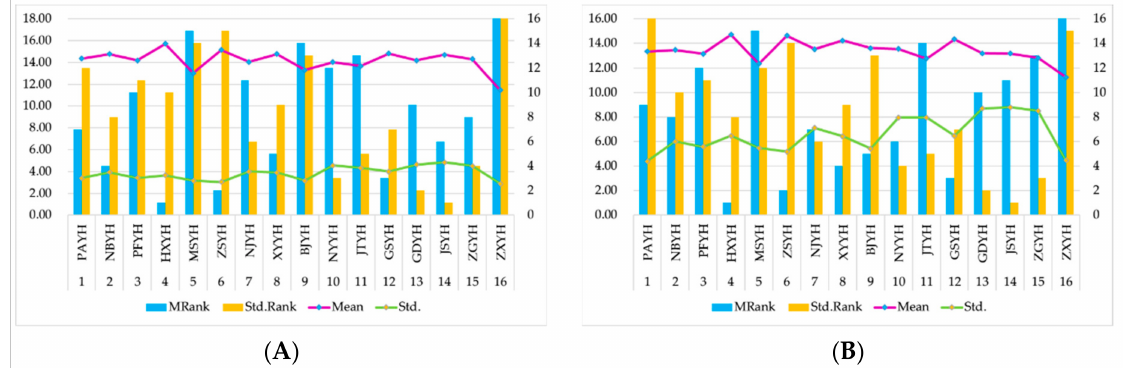
Figure 8. The results of the mean and standard deviations of ∆ CoVaR (In the figure, we calculate the daily ∆ CoVaR (the di ff erence between the Conditional Value at Risk (CoVaRs) when the bank is in distress and in a normal state) of each bank, and then derive the corresponding mean and standard deviation for each bank): ( A ) 2013; ( B )